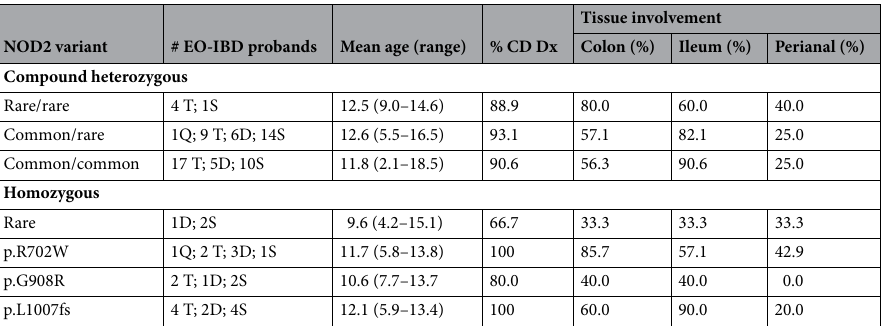
Table 1. Mutation spectrum of recessive NOD2 variants in an EO-IBD cohort. Common NOD2 variants refer to the three main low-frequency Crohn’s Disease risk variants p.R702W, p.G908R, and p.L1007fs; Rare NOD2 variants refer to other low-frequency variants (MAF ≤ 5%). Q, quartet; T, trio; D, duo; S, singleton; Dx,